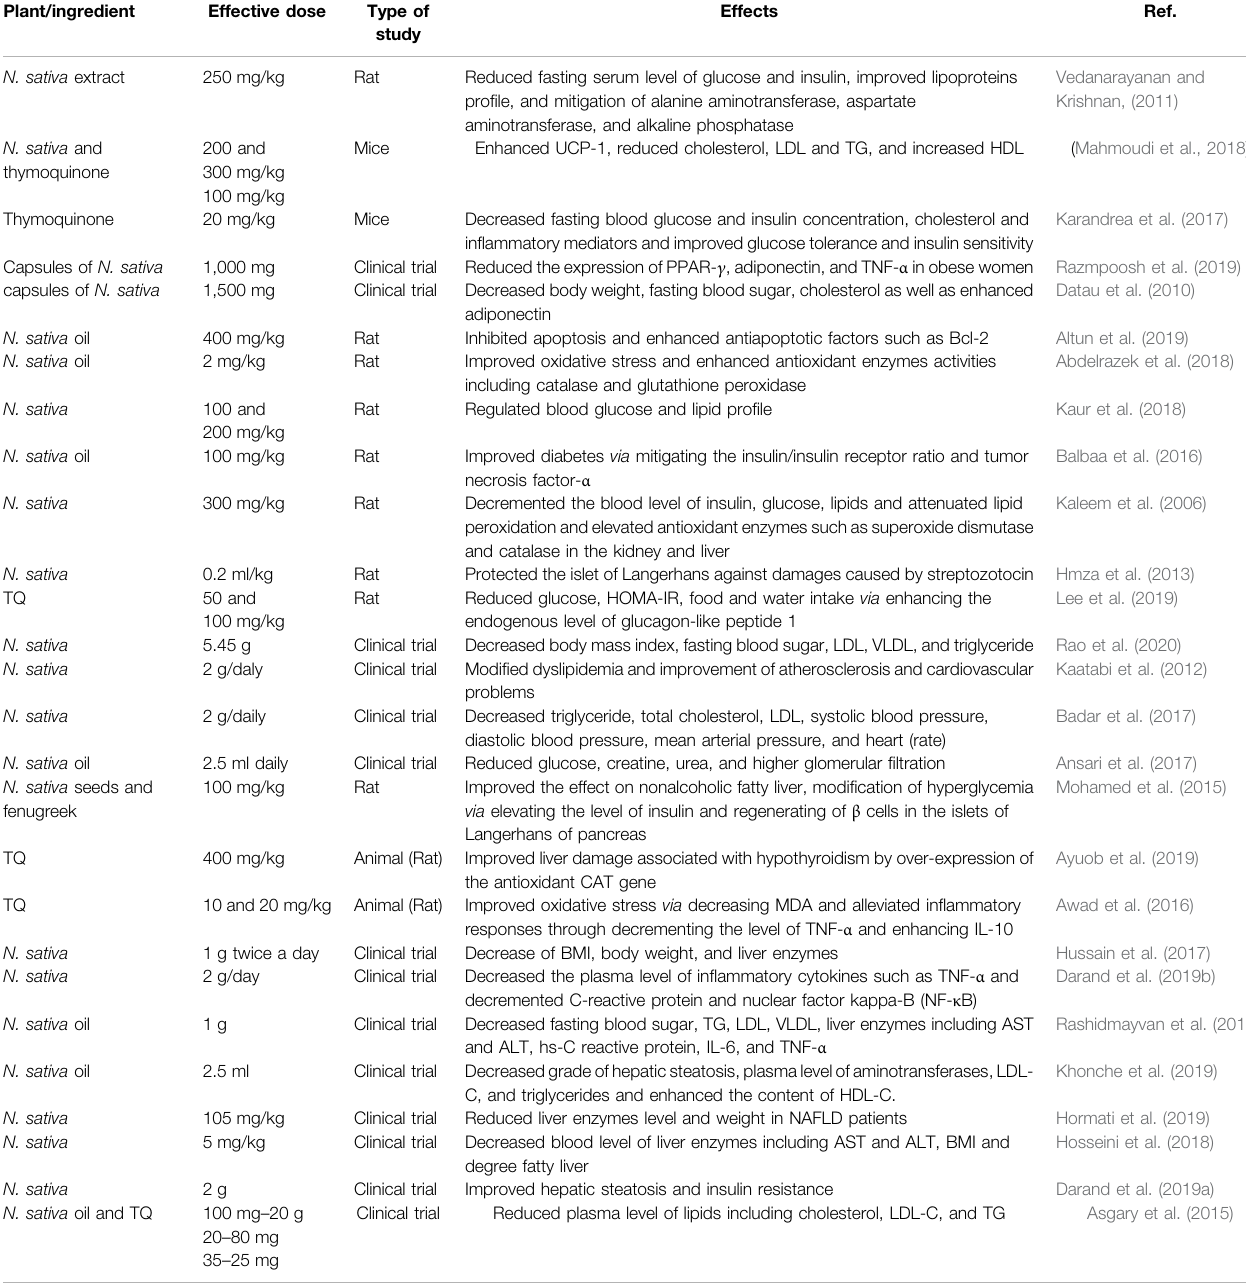
TABLE 1 | Effects of N. sativa and its ingredients on obesity, diabetes mellitus, and nonalcoholic fatty liver disease.